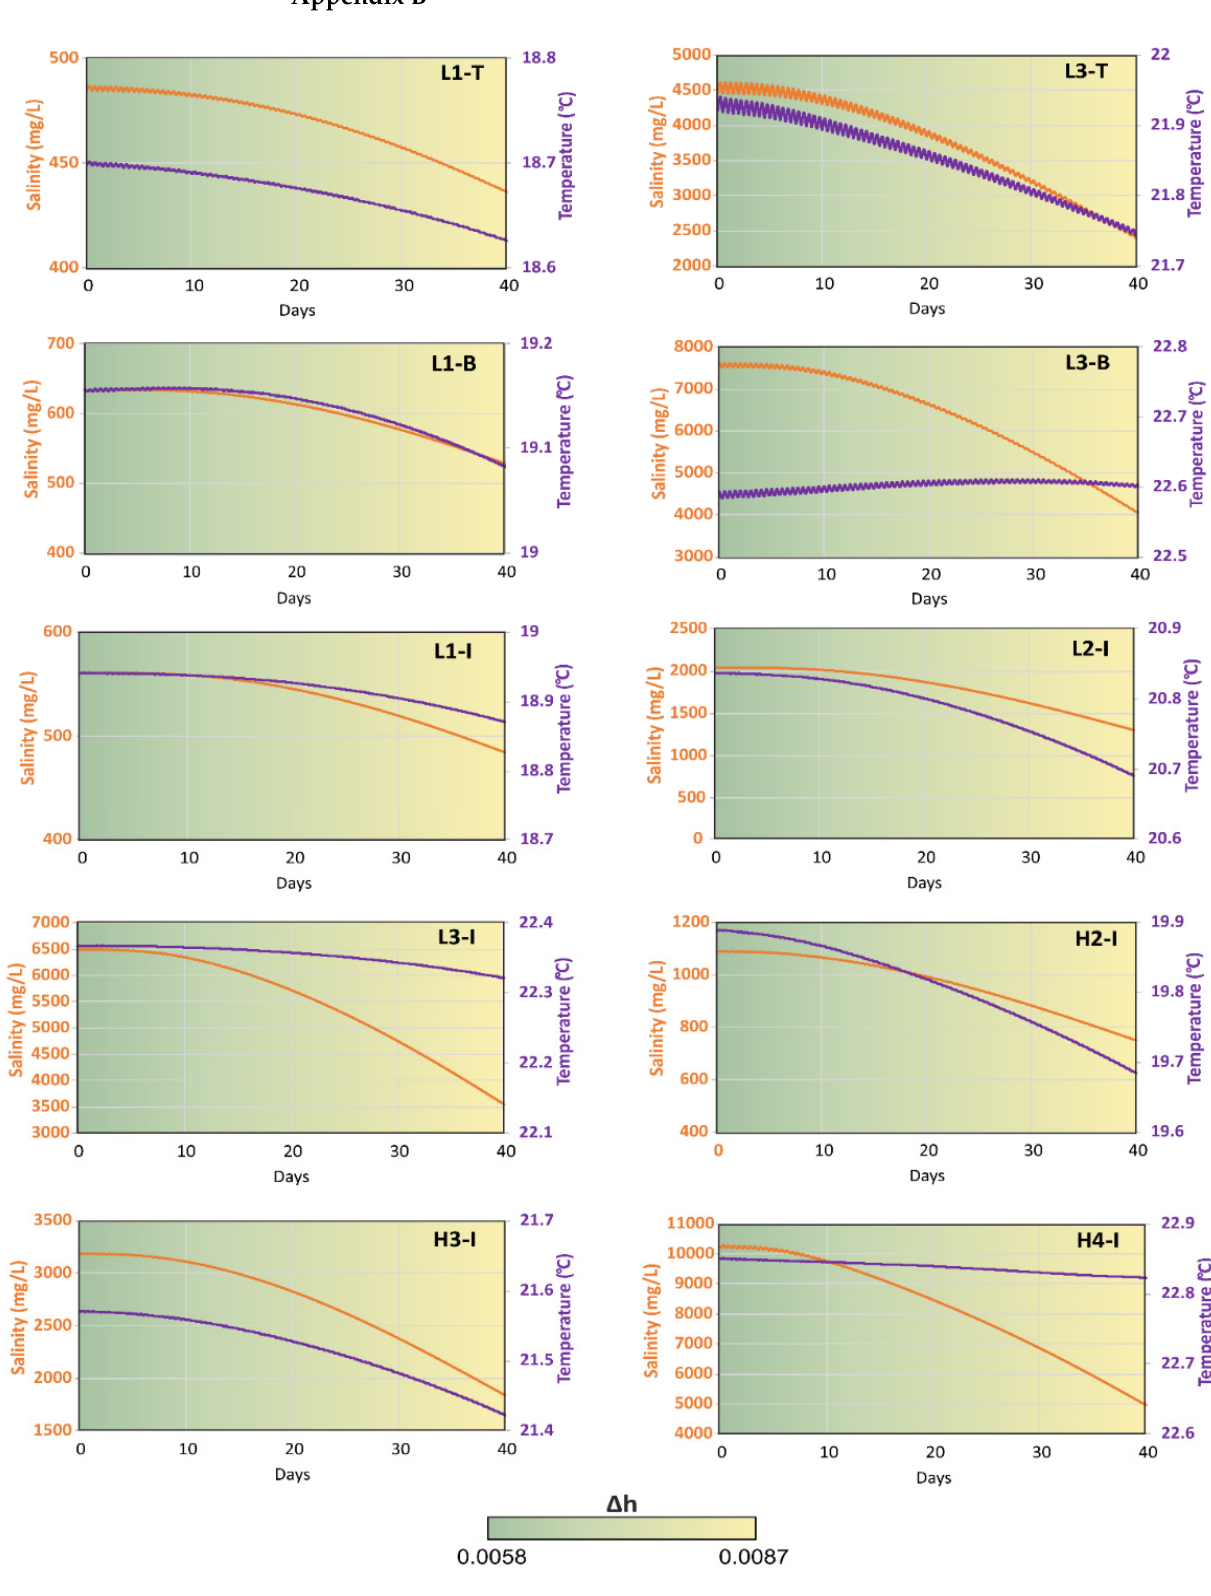
Figure A2. Simulation results of model C at different depths of the well W for a mesotidal condition (semi-amplitude of 1.5 m).